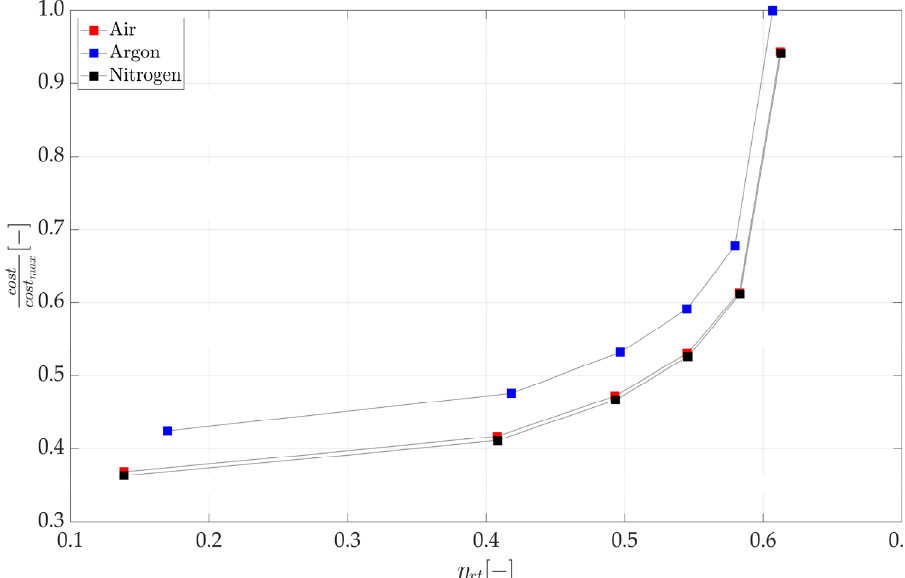
Figure 4. The trade-off (Pareto fronts) between cost and roundtrip efficiency for the LBPTES system. The results are related to air, argon and nitrogen; the cost was normalised with its maximum value to highlight the relative cost increments along the fronts and between the different fluids.